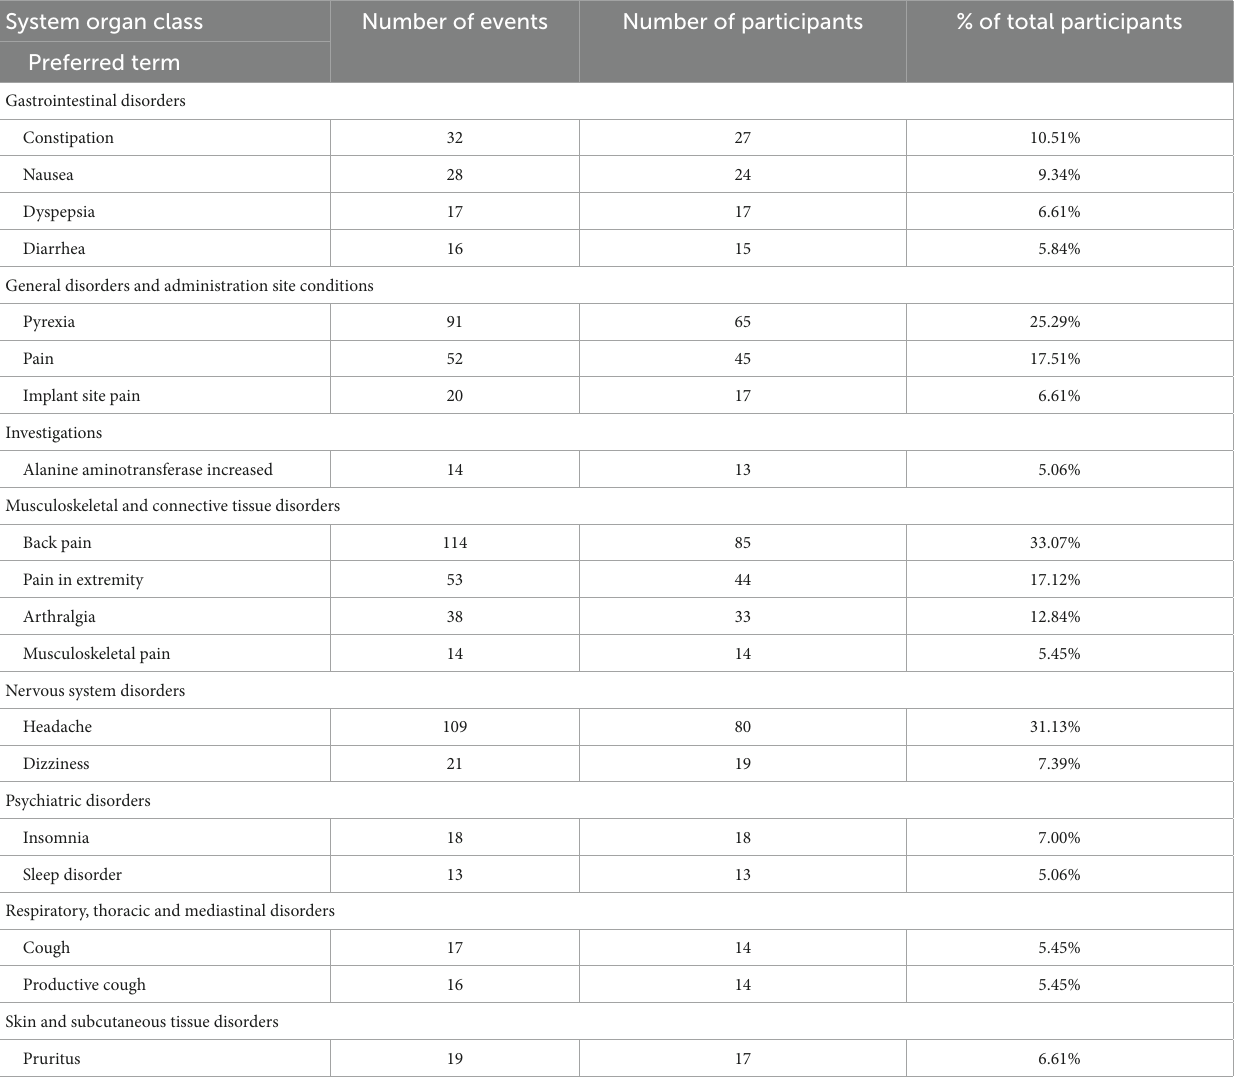
TABLE 2 Summary of adverse